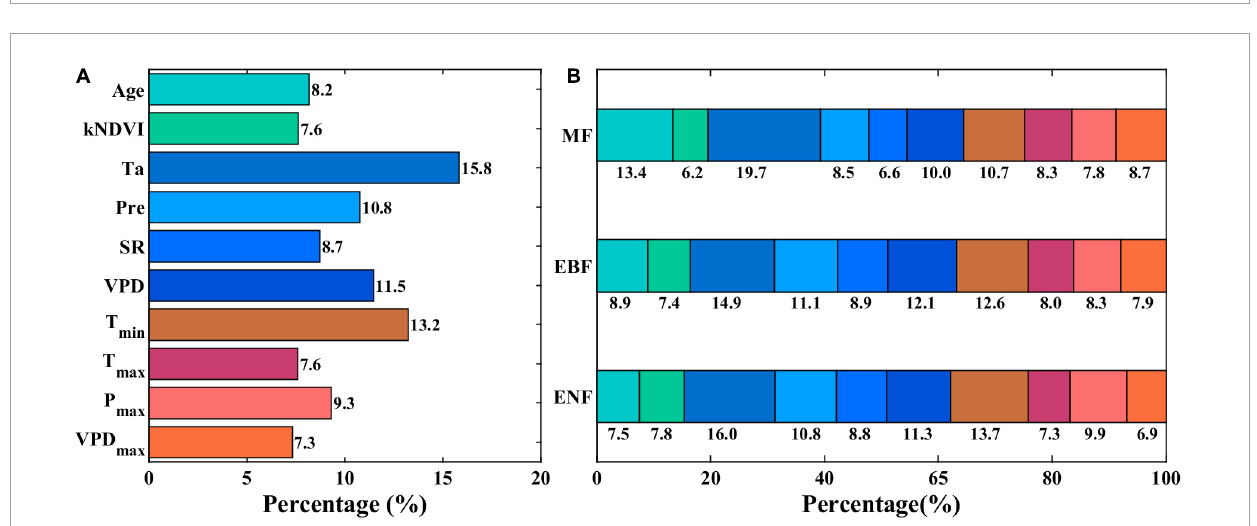
FIGURE7 Variable importance of selected environmental variables for explaining the AC1 time series in each grid of subtropical evergreen forests in China. (A) Cover percentages of different most influential environmental variables. (B) Cover percentages of the most influential variables across the plant functional